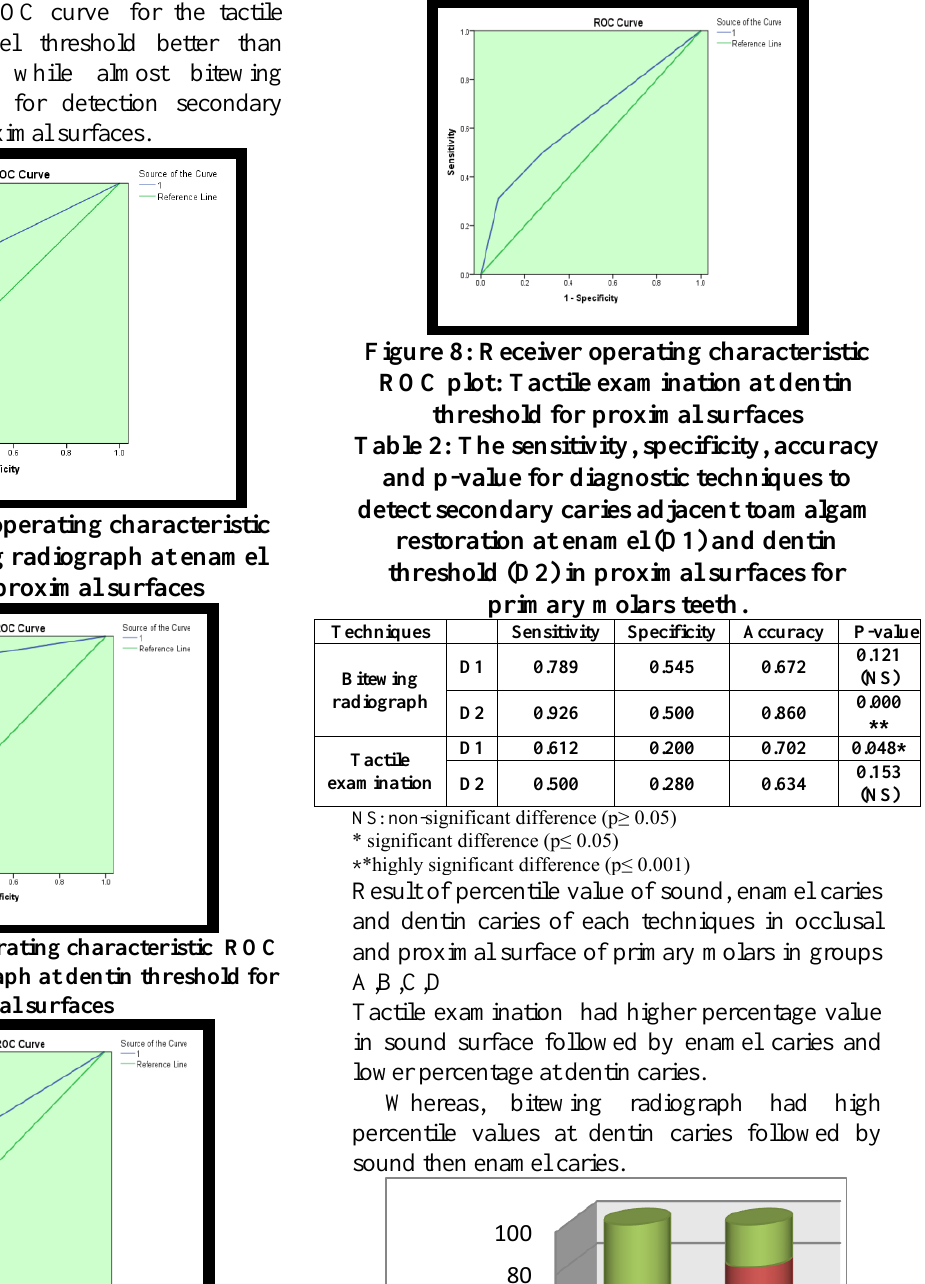
Figure 7: Receiver operating characteristic ROC plot: Tactile examination at enamel threshold for proximal surfaces